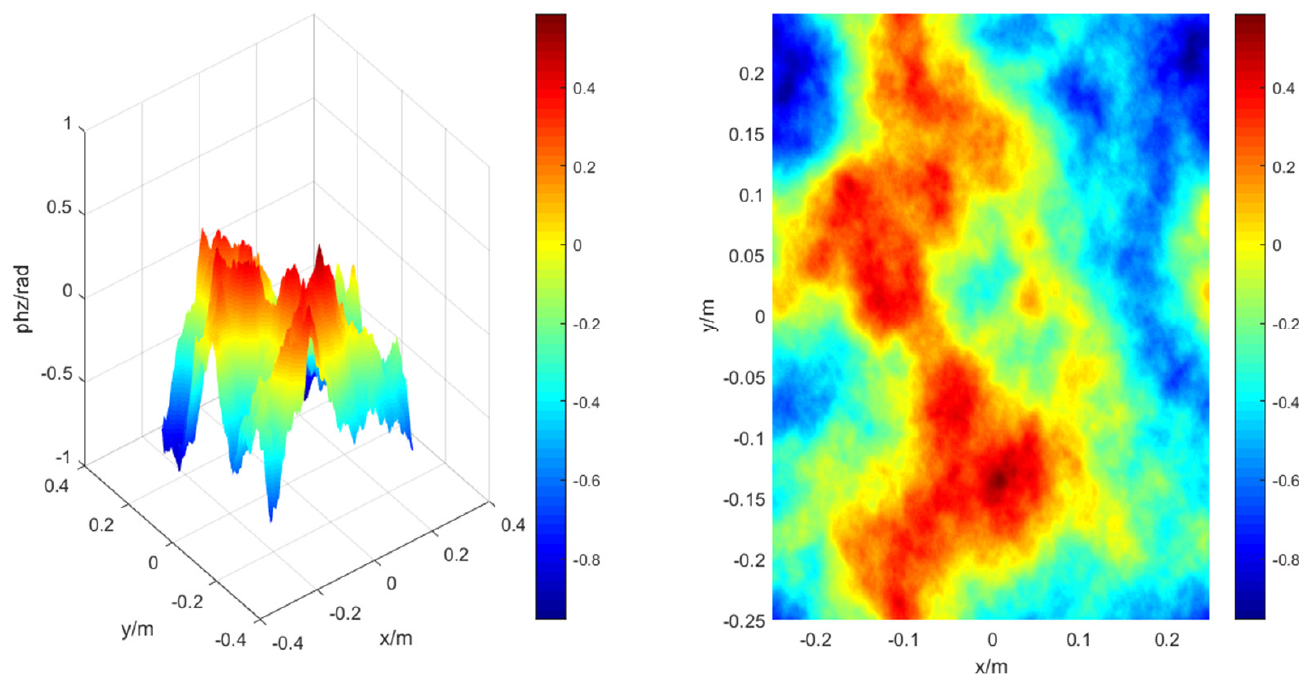
Figure 7. The three-dimensional ( left ) and two-dimensional ( right ) schematic diagrams of the phase distribution of the high-frequency phase screen numerically simulated in the turbulent atmosphere.